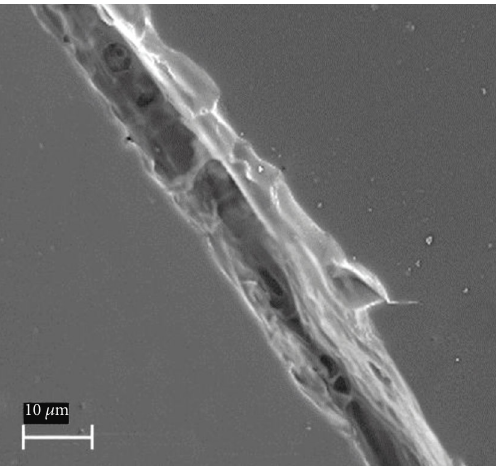
Figure 11: SEM micrographs of scratched and immersed coating containing 1wt% of MCs after the healing process.